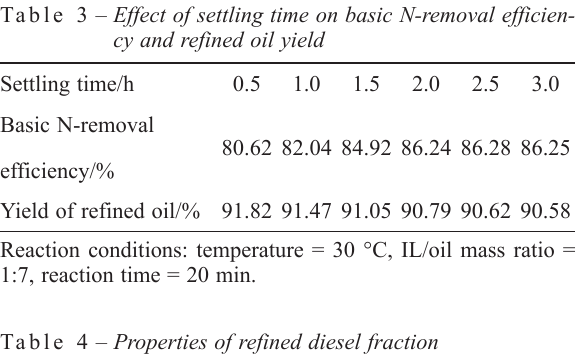
Table 4 – Properties of refined diesel fraction Ρ /g mL 20